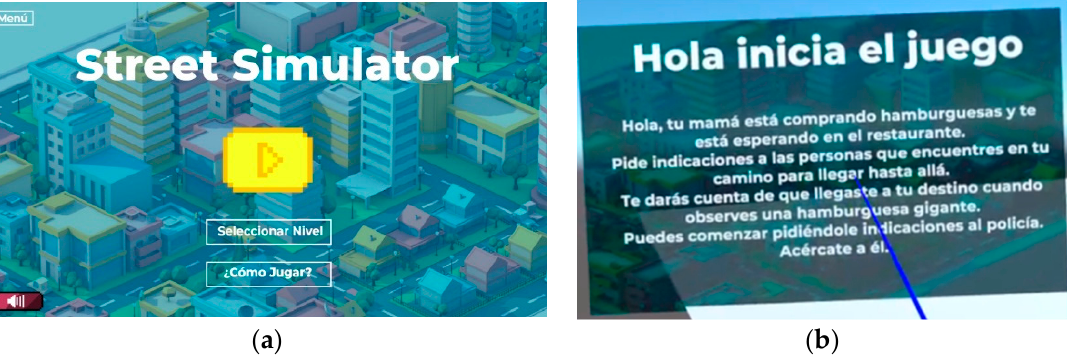
Figure 8. ( a ) Initial menu of the video game “Street Simulator” with level selection and how to play options (“Seleccionar Nivel”, “Como Jugar”). ( b ) Initial instruction to know the destination to go to. Once inside the environment, instructions are provided through audio and text to offer different means of representation to access the information. In the virtual environment, it is possible to encounter different avatars representing police officers who give instructions to reach the established objective when the user approaches them (see Figure